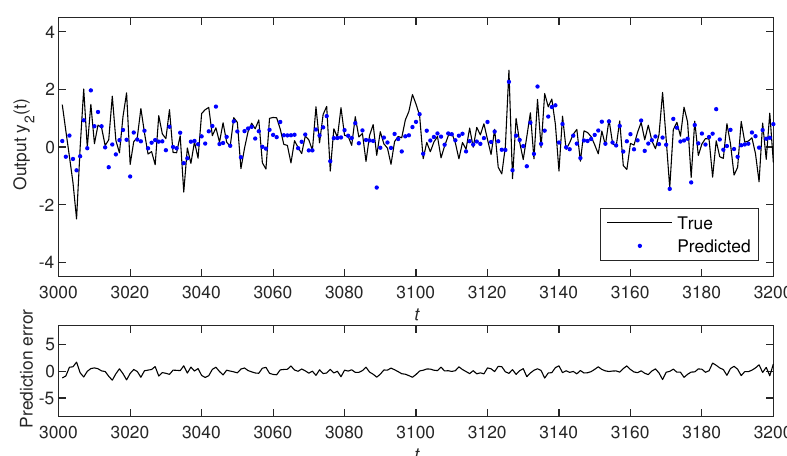
Figure 7. The true output, the predicted output of y 2 ( t ) and the prediction